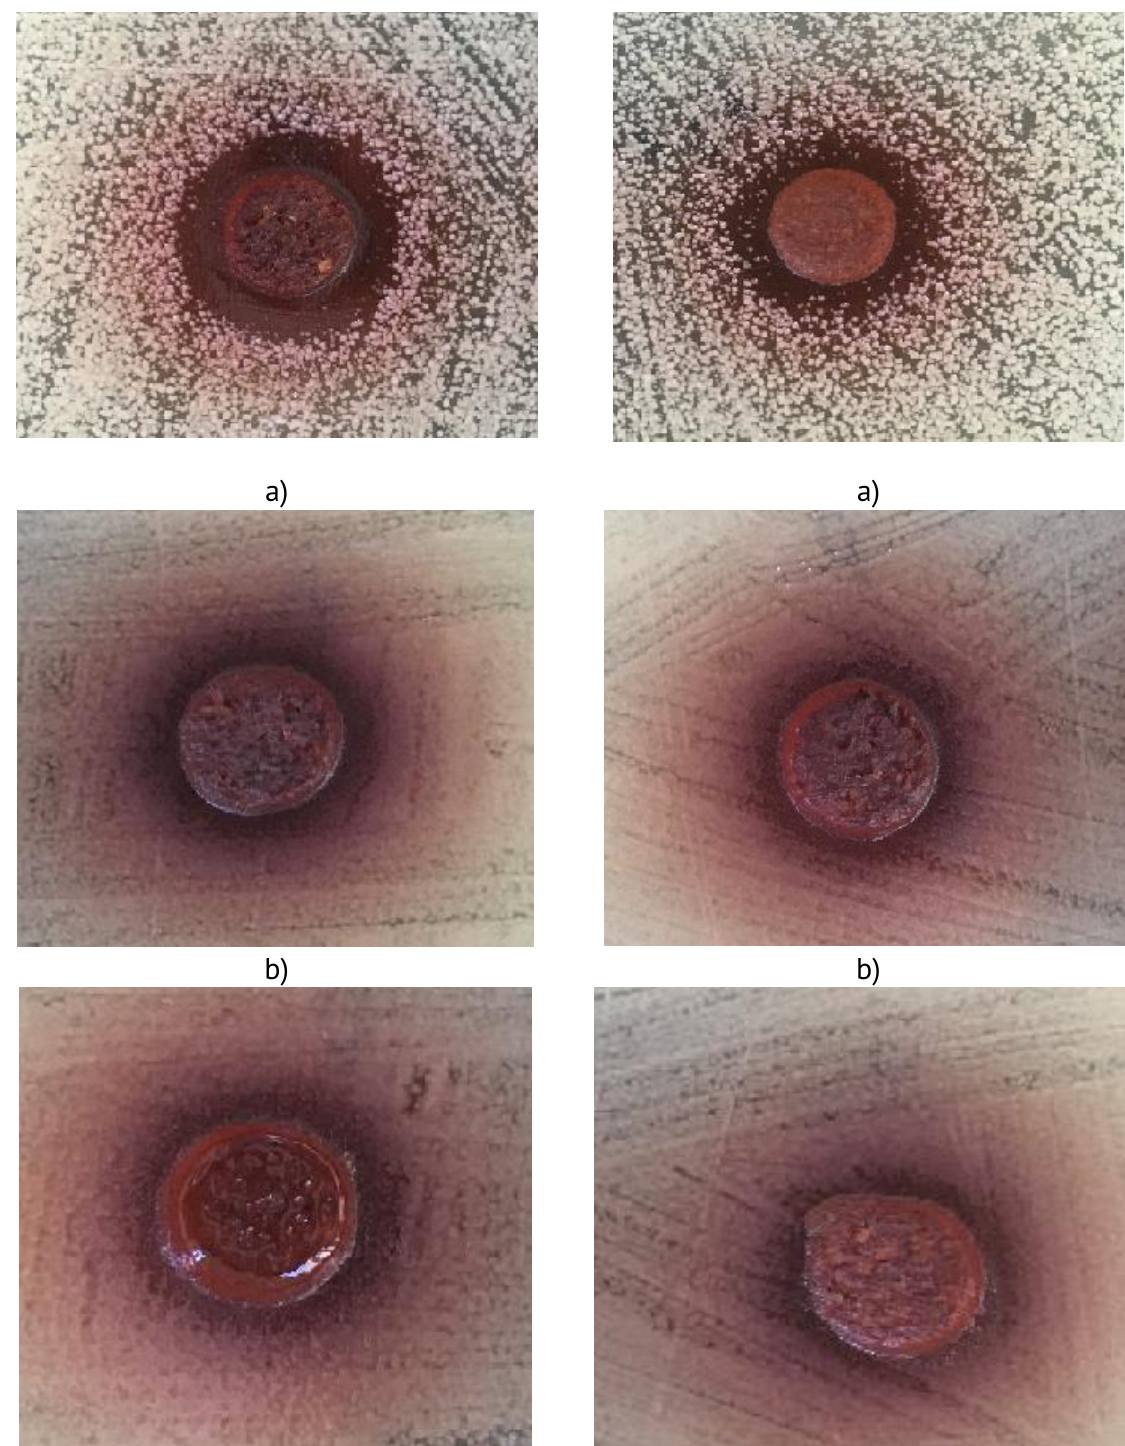
Figure 1. The antimicrobial action of rose hip powders on: a) Staphylococcus aureus ; b) Escherichia coli ; c) Klebsiella pneumonia.